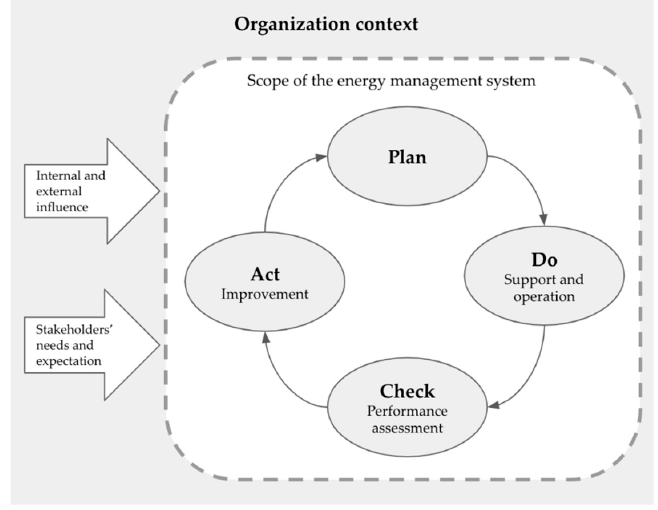
Figure 1. Plan–do–check–act (PDCA) cycle. Adapted from [25].